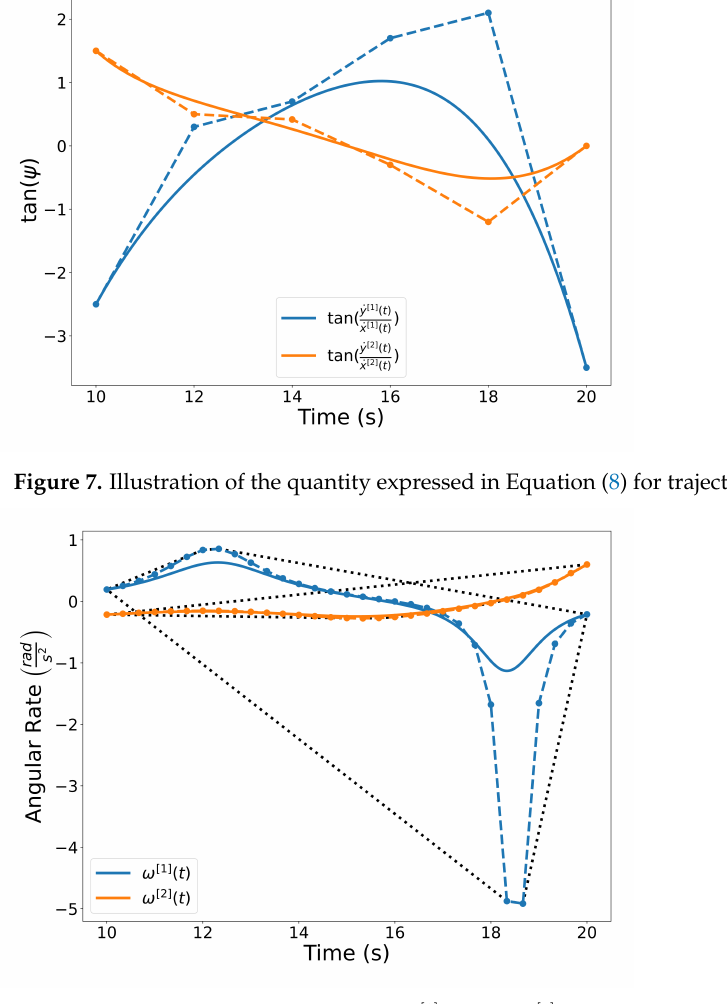
Figure 8. Angular rates of trajectories C [ 1 ] ( t ) and C [ 2 ] ( t ) . Note that the angular rates are rational Bernstein